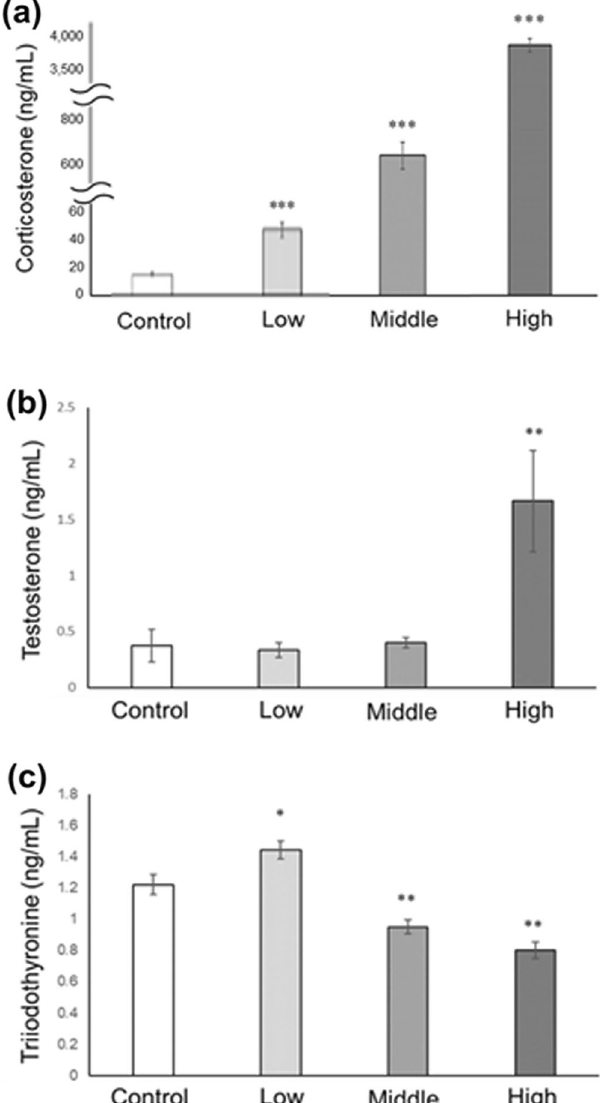
Figure 1. Serum CORT, testosterone, and T3 levels in CORT-administered mice on PND 10. Serum CORT ( a ), testosterone ( b ), and T3 ( c ) levels on PND 10 were assessed using ELISA. Values are expressed as the mean ± S.E.M of 12 samples per group. *p < 0.05, **p < 0.01, and ***p <